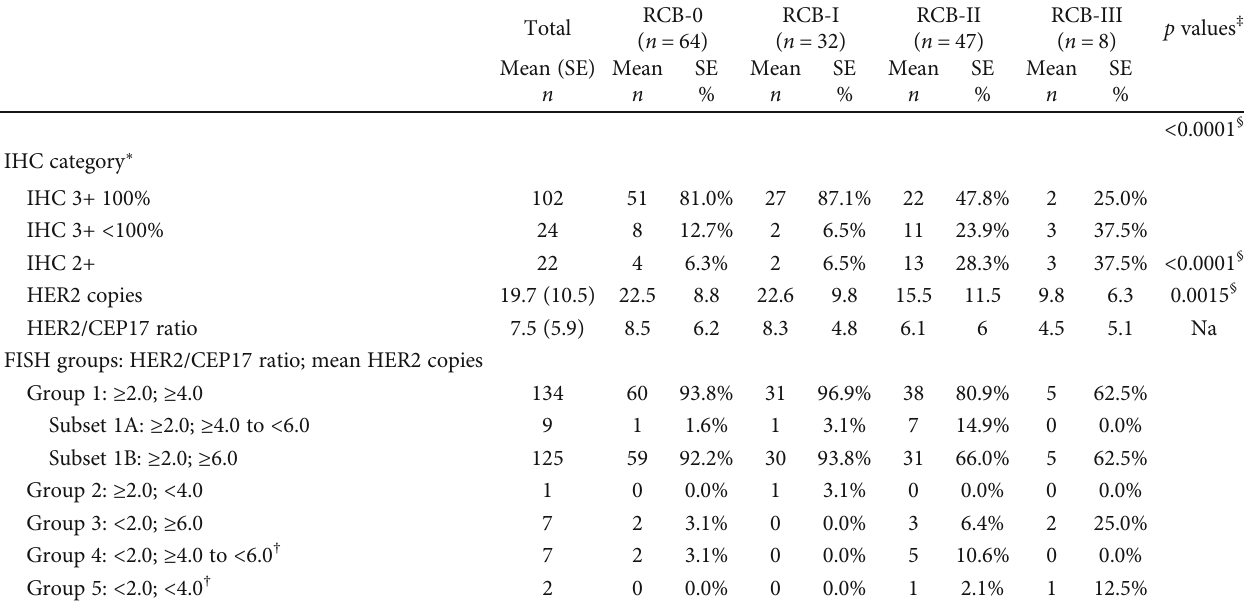
Table 3: HER2 characteristics of HER2+ cases receiving neoadjuvant